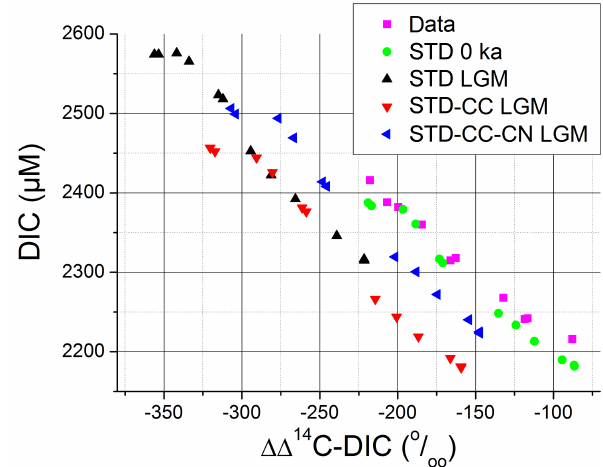
Figure 13. DIC vs. difference between radiocarbon in seawater DIC and atmospheric CO 2 ( (cid:49)(cid:49) 14 C-DIC) at >2000m water depth. Data are mean values for deep water and bottom water boxes de- rived from water column measurements. Model results are shown for the standard case (STD), for constant circulation (STD-CC), and constant values for circulation and nutrient utilization (STD- CC-CN). LGM refers to model results at